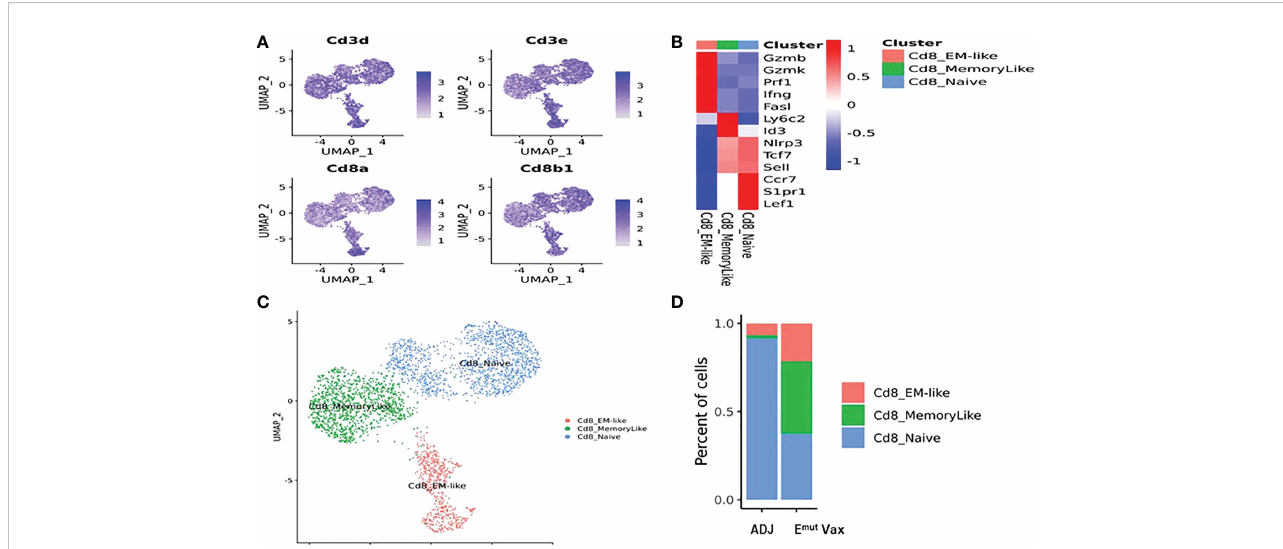
FIGURE 7 E mut Vax treatment increased anti-tumor CD8 + cytotoxic T cells within tumor-bearing lungs. (A) Canonical CD8+ T cell marker expression based on scRNA-seq data. (B) Heatmap of the expression markers for each CD8 + T cell subset. (C) Distribution of each CD8 + T cell subset; (D) Percent changes of the CD8 + T cells subsets across adjuvant control and E mut Vax treatment groups. CD8_EM-like: P = 0.013; CD8_MemoryLike: P = 0.007; CD8_Naive: P =